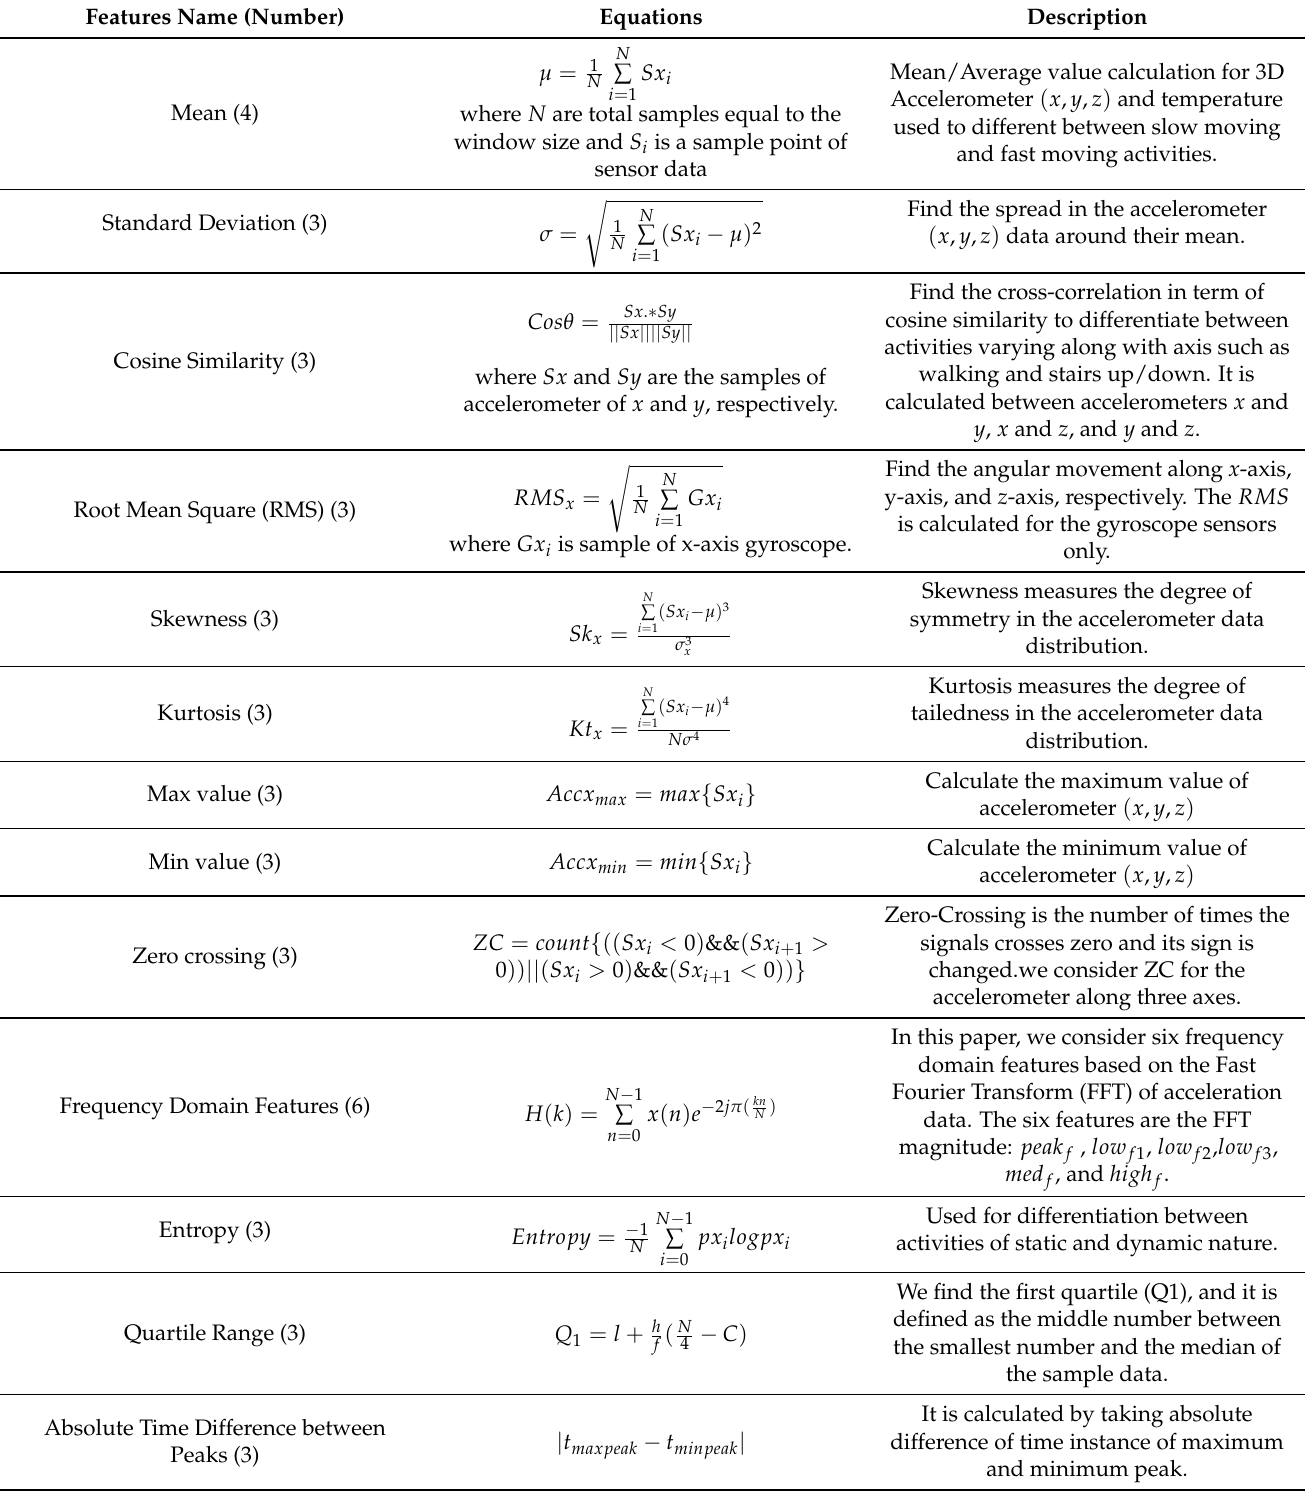
Table 5. Feature extraction from sensor